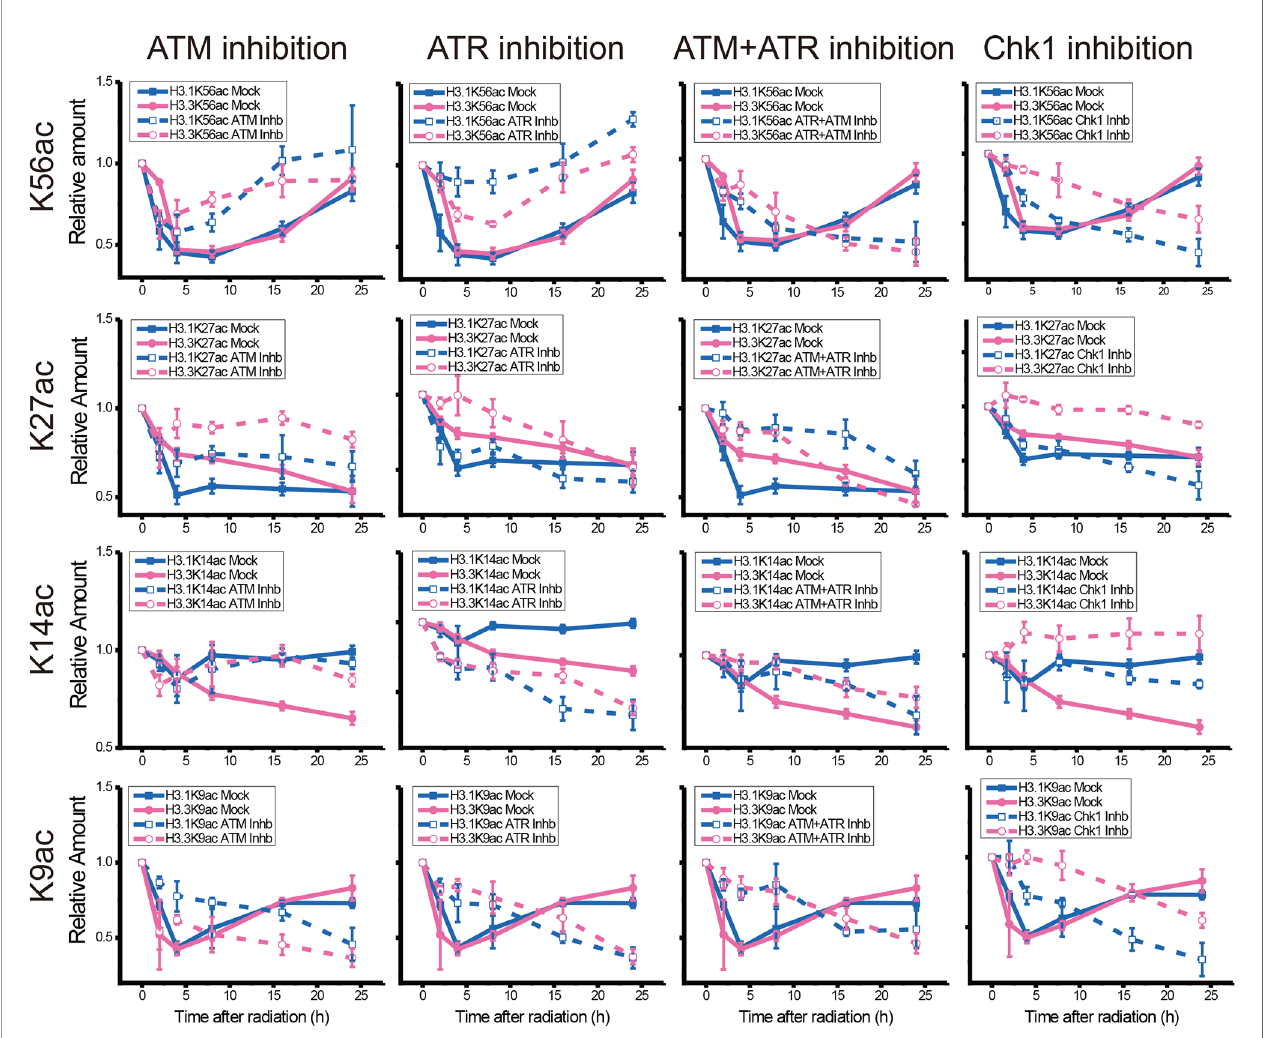
FIGURE 6 | Comparison of the acetylation levels of K9, K14, K27, and K56 of histone H3.1 and H3.3 in irradiated U2OS cells. For each acetylation site, the relative amounts of H3.1 and H3.3 acetylation before and after chemical treatment were compared